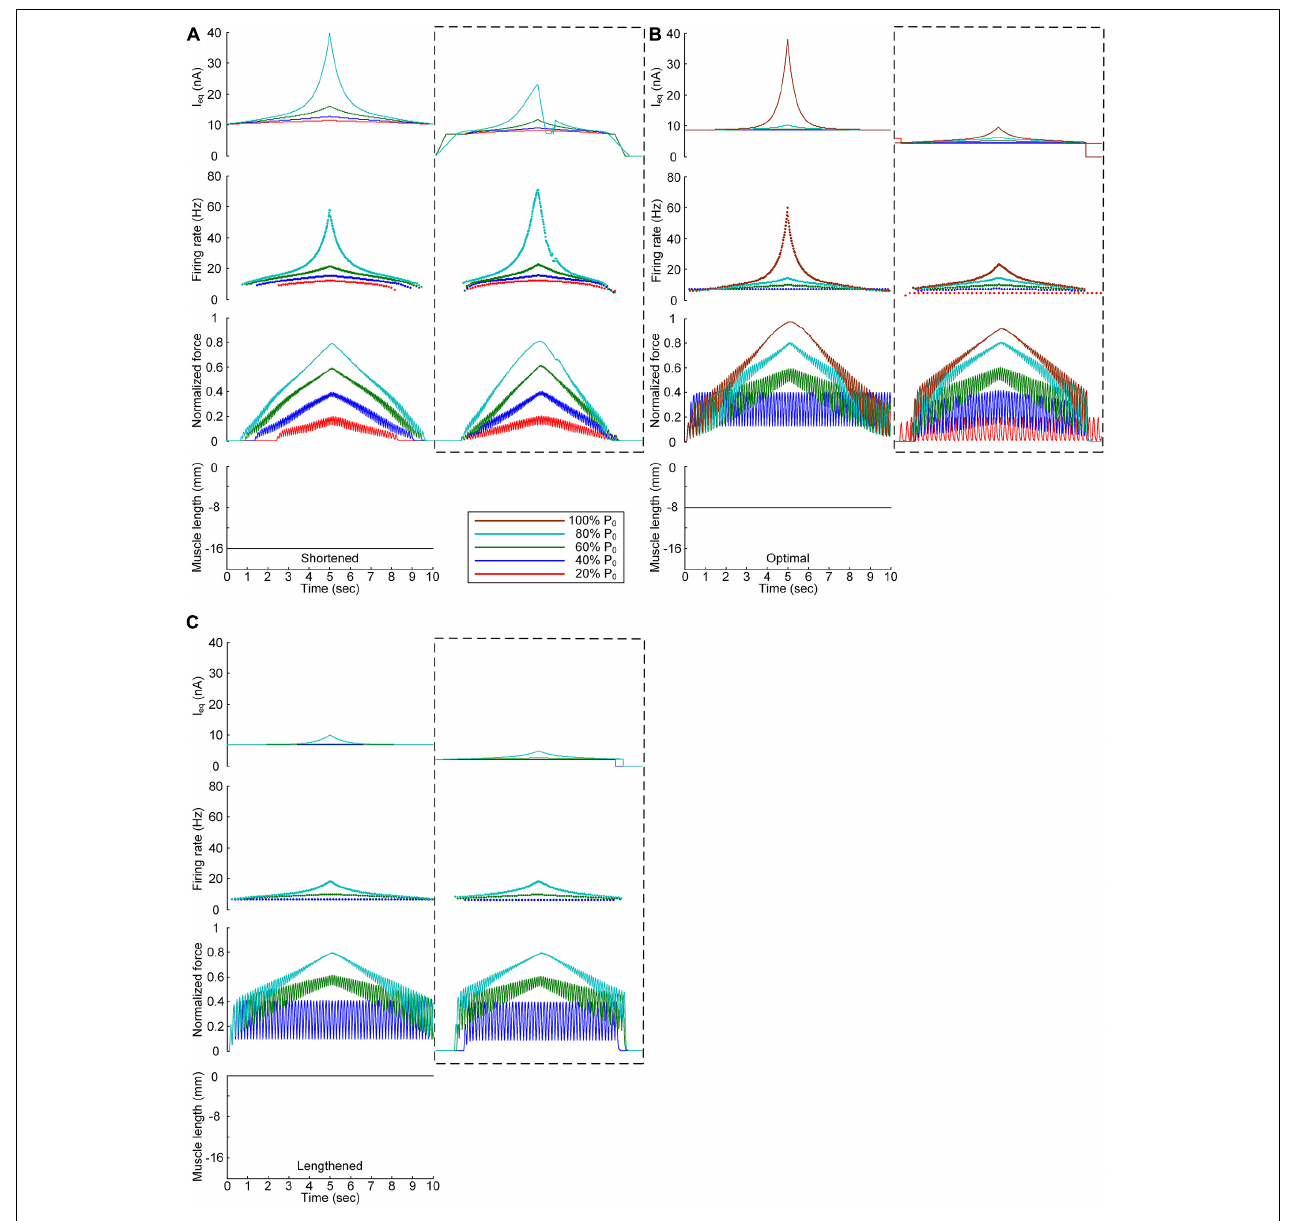
FIGURE 5 | Influence of the PIC on the stimulation waveforms under the continuous conditions. Intensities of continuous current stimulation ( I eq ) applied to the somatic compartment ( top ), instantaneous firing rate ( upper middle ) in the motoneuron, and normalized muscle force ( lower middle ) generated by the muscle unit at the three muscle lengths ( bottom ): physiologically minimum (A) , optimal (B) , and maximum muscle lengths (C) . The level of force production produced by the motor unit is denoted as a percentage of the maximal isometric force (P 0 ) at the optimal muscle length and indicated with different colors. The dashed-line rectangles indicate the simulation results with the motoneuron PIC channels, as shown in Figure 3 , for the purpose of